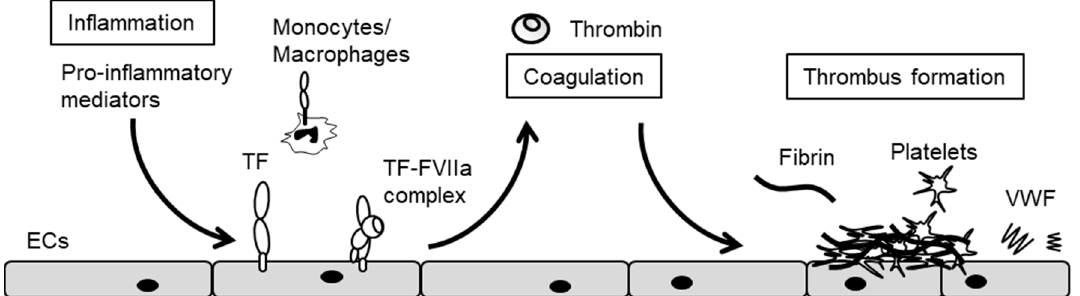
Figure 2. ECs initiate the blood coagulation cascade in response to pro-inflammatory stimuli. Pro-inflammatory mediators induce tissue factor (TF) expression in ECs and initiate a blood coagulation cascade. Thrombin generates fibrin and activates platelets resulting in thrombus formation.